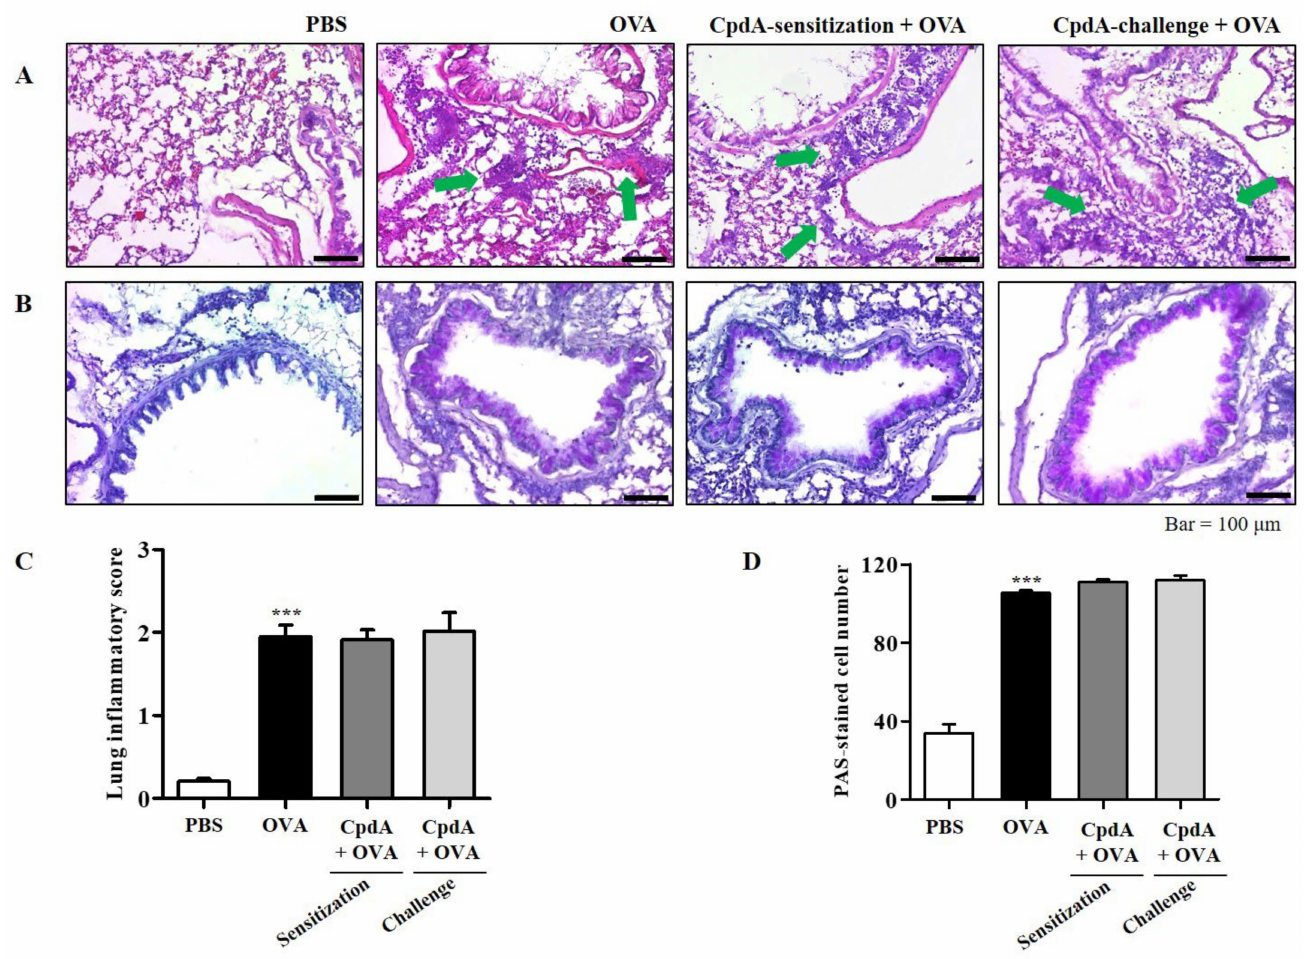
Figure 7. Compound A does not protect against airway inflammation and mucin secretion in FFA4- KO mice. ( A ) Panels show H&E-stained sections of lung tissues from the PBS group, OVA group, and compound A-treated OVA groups (before sensitization or before challenge). Small dark-blue dots around the bronchioles indicate eosinophils. Eosinophils are accumulated around bronchioles in the OVA group (green arrows). ( B ) Panels show PAS/hematoxylin-stained sections of lung tissues from the PBS group, OVA group, and compound A-treated OVA groups (before sensitization or before challenge). In PAS staining, mucin is stained as a purple color. Darker and thicker purple coloring is observed surrounding the bronchiole in the OVA group compared to the PBS group. ( C ) Lung inflammation was semi-quantitatively evaluated; histological findings were scored as described in Section 4. ( D ) Mucous production was measured by counting the number of PAS-positive cells per mm of bronchiole ( n = 5 per group). Values represent the mean ± SEM ( n = 5). *** p < 0.001 vs. the PBS-treated